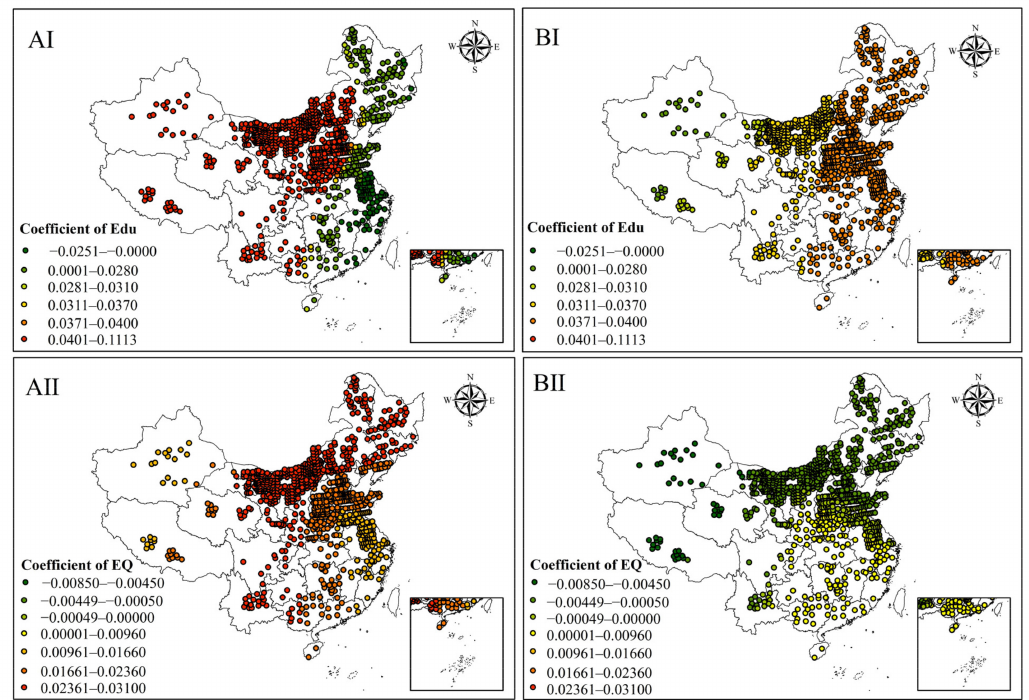
Figure 6. The effects of education ( above ) and environmental quality ( below ) in describing WTPEP before ( left ) and during ( right ) COVID-19 based on MGWR